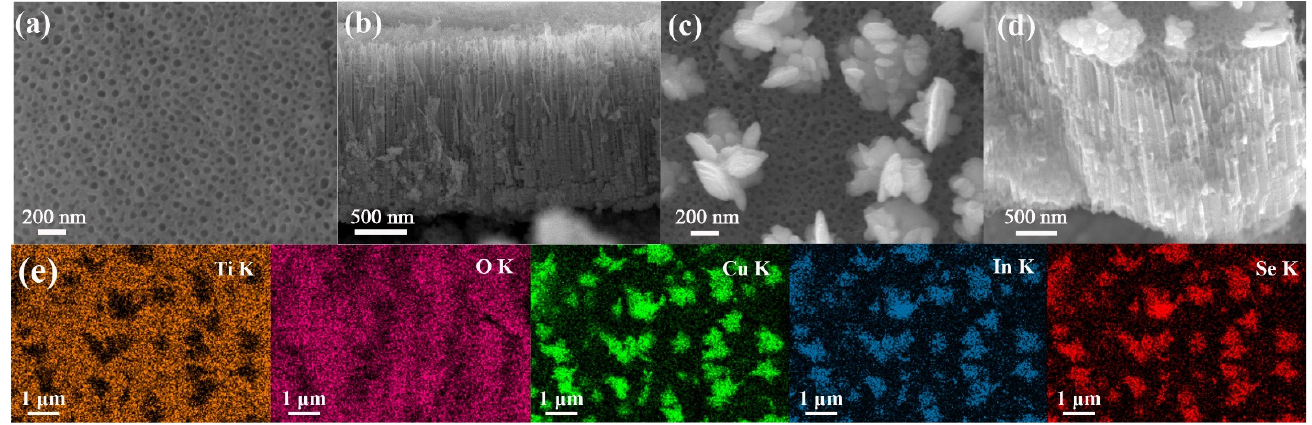
Figure 2. ( a ) SEM Top ‐ view and ( b ) cross ‐ section of the TiO 2 NTAs, ( c ) SEM top ‐ view, ( d ) cross ‐ section view of the CuInSe 2 /TiO 2 ‐ B NTAs, and ( e ) EDS elemental mapping of the CuInSe 2 /TiO 2 ‐ B